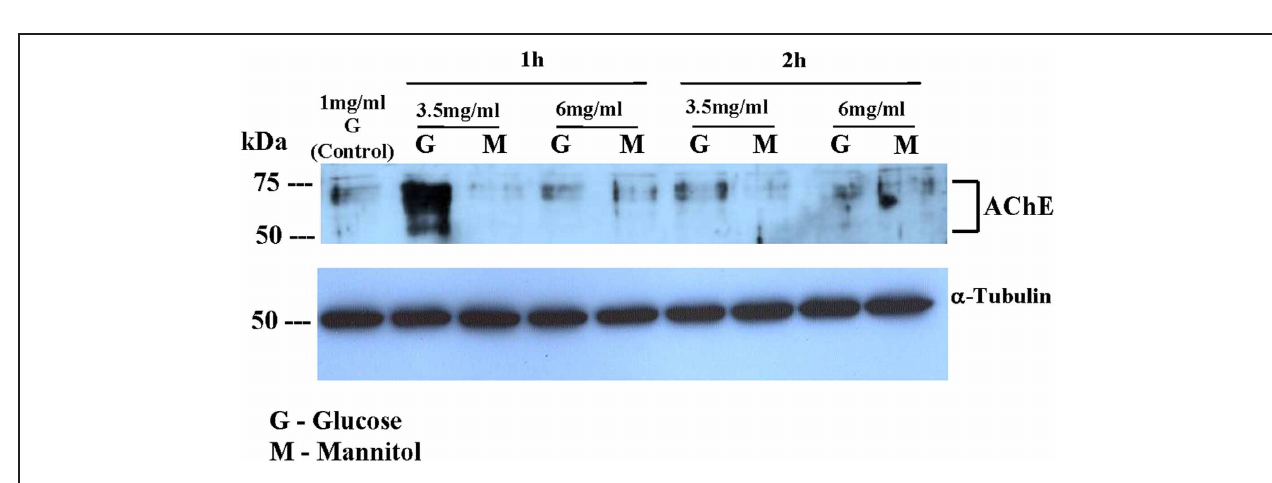
FIGURE 3 | AChE expression in Y79 cells treated by adding glucose or mannitol. Y79 cells were treated first for 16–24h in starvation medium (1% FBS and 1mg/ml glucose), and then incubated with 3.5mg/ml or 6mg/ml of glucose or mannitol for 1 or 2h. Following 1 or 2h incubation